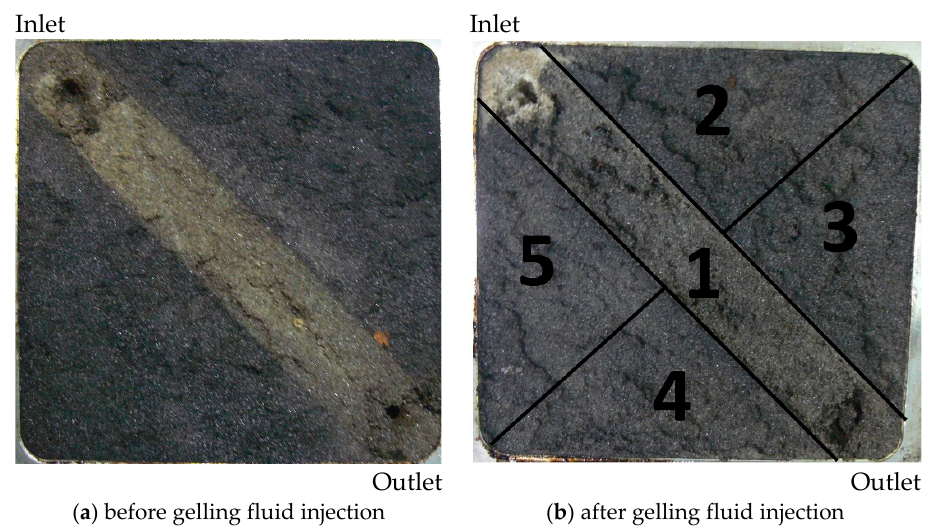
Figure 9. Water drive effect before and after gelling fluid injection (heterogeneous plate model).